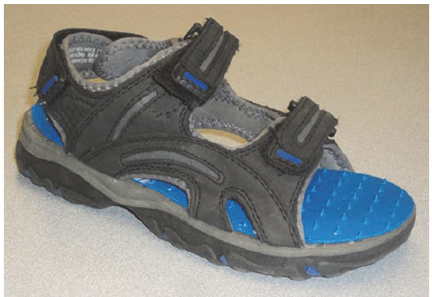
Figure 1: Textured insole inserted in the sandal.